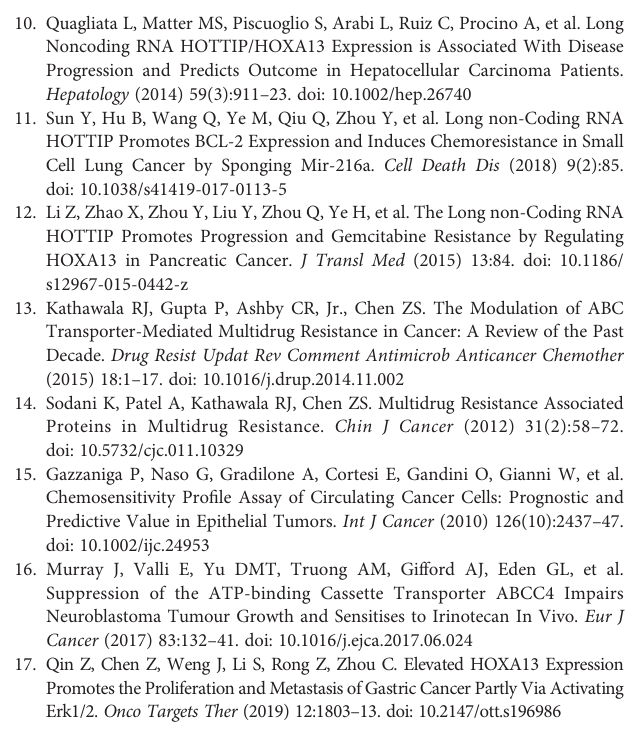
Supplementary Figure 1 | (A) Establishment of HOXA13-overexpressing cell lines in AGS and MKN28 cells, con fi rmed by qRT-PCR. (B) Establishment of HOXA13 knockdown cell lines in SGC7901 and MKN45 cells, con fi rmed by qRT- PCR. (C) The binding sites of HOXA13 in ABCC4 promoter region were predicted by JASPAR database and primer sequences were designed. *** P <